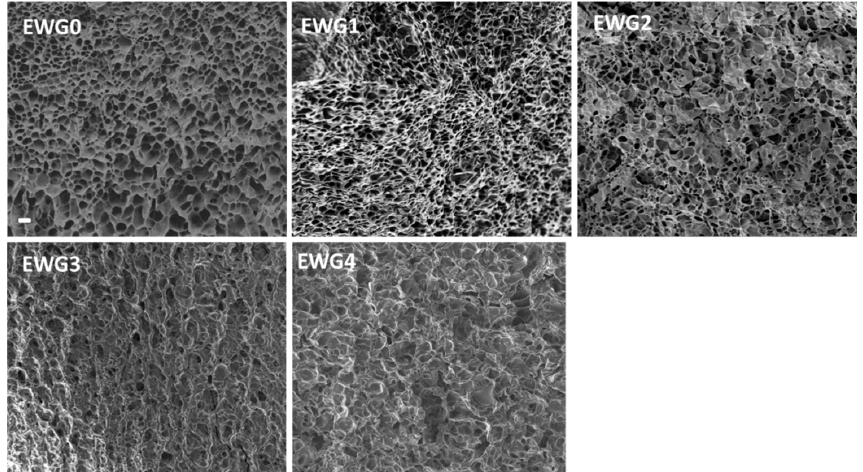
Figure 3. SEM images of the hydrogels. The scale bar is 10